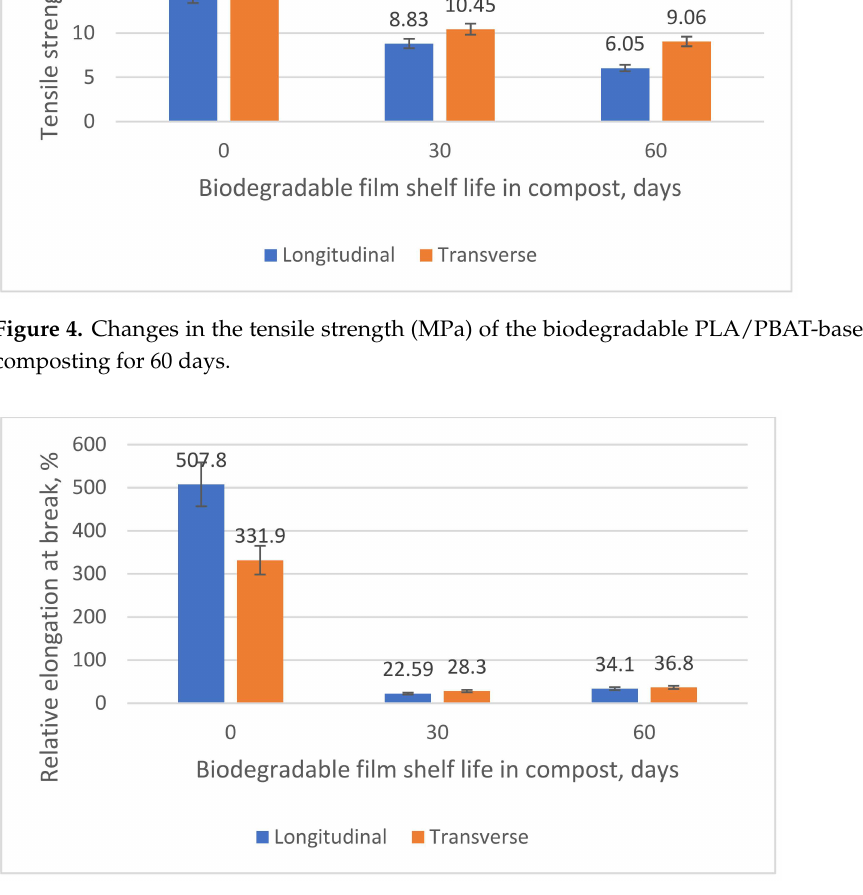
Figure 5. Changes in the relative elongation at break (%) of the biodegradable PLA/PBAT-based film after composting for 60 days. Table 3. Decrease in the physical and mechanical properties of the biodegradable PLA/PBAT-based film after soil